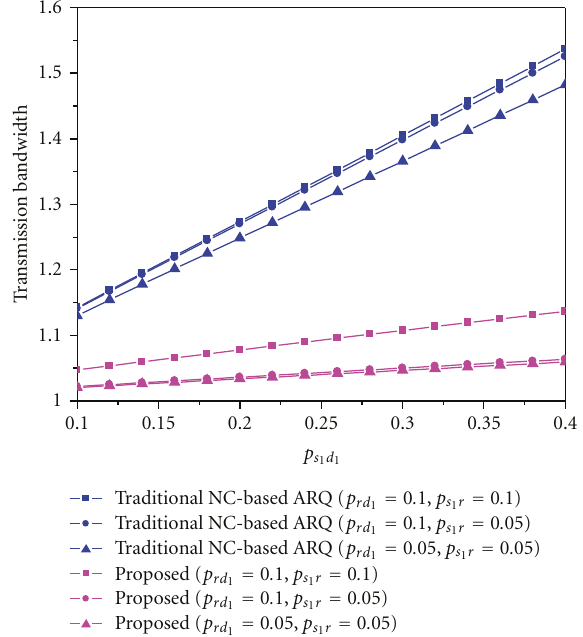
Figure 7: Transmission bandwidth of traditional NC-based ARQ and our proposed protocol over p s p . 1 and di ff erent p s 1 d 1 + 0